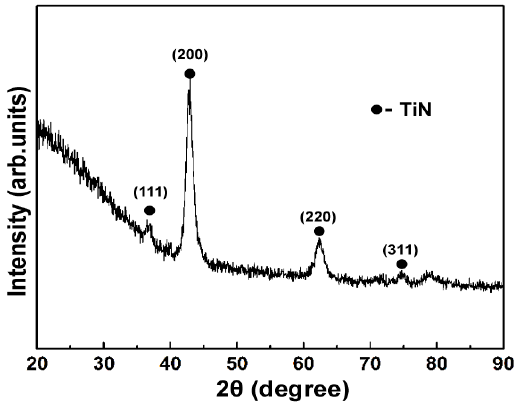
Figure 2. XRD pattern of the TiN/SiO x duplex coating.